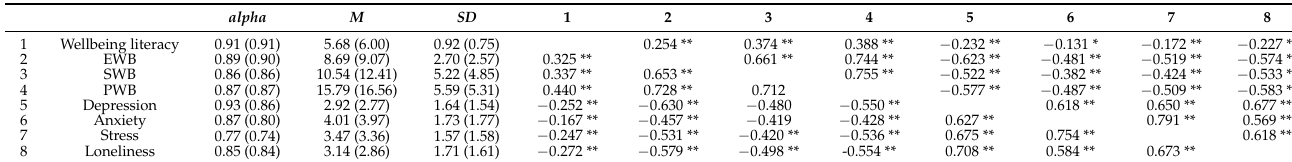
Table 4. Correlations between the study variables in the parent and staff